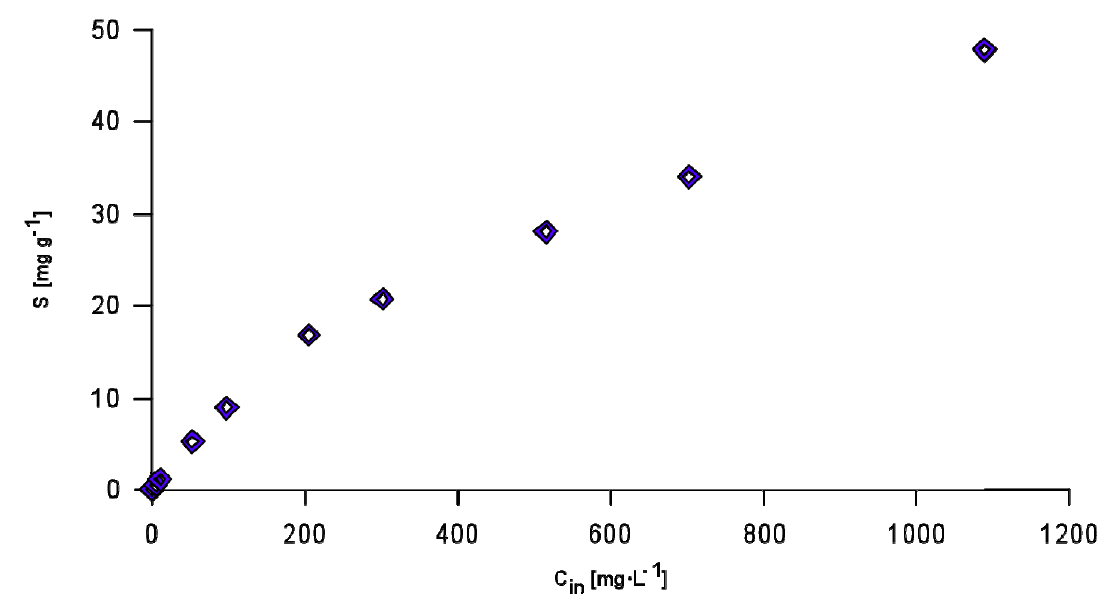
Figure 3. Phosphorus sorption isotherm for